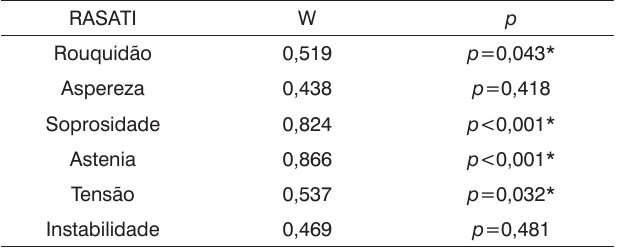
Tabela 2. Análise de concordância entre as avaliações per- ceptivo-auditiva das vozes, pelos juízes fonoaudiólogos, por meio da escala